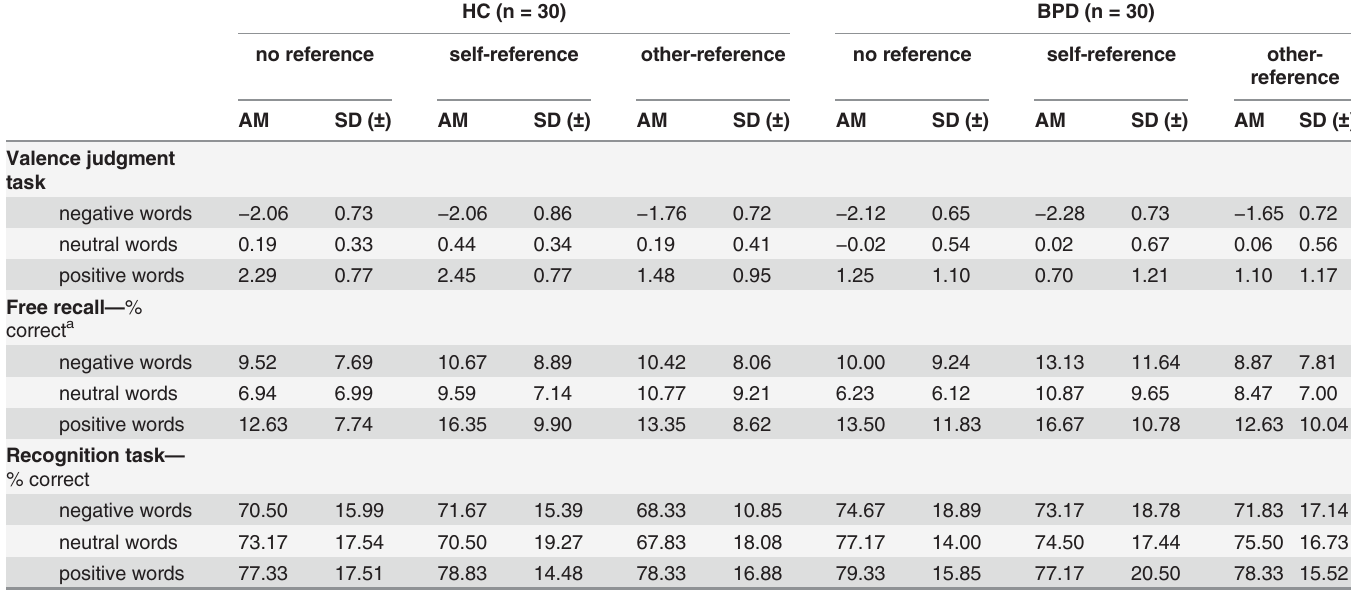
Table 2. Rating scores in the word valence judgment task and performance in the memory tasks in healthy control participants (HC) and patients with Borderline Personality Disorder